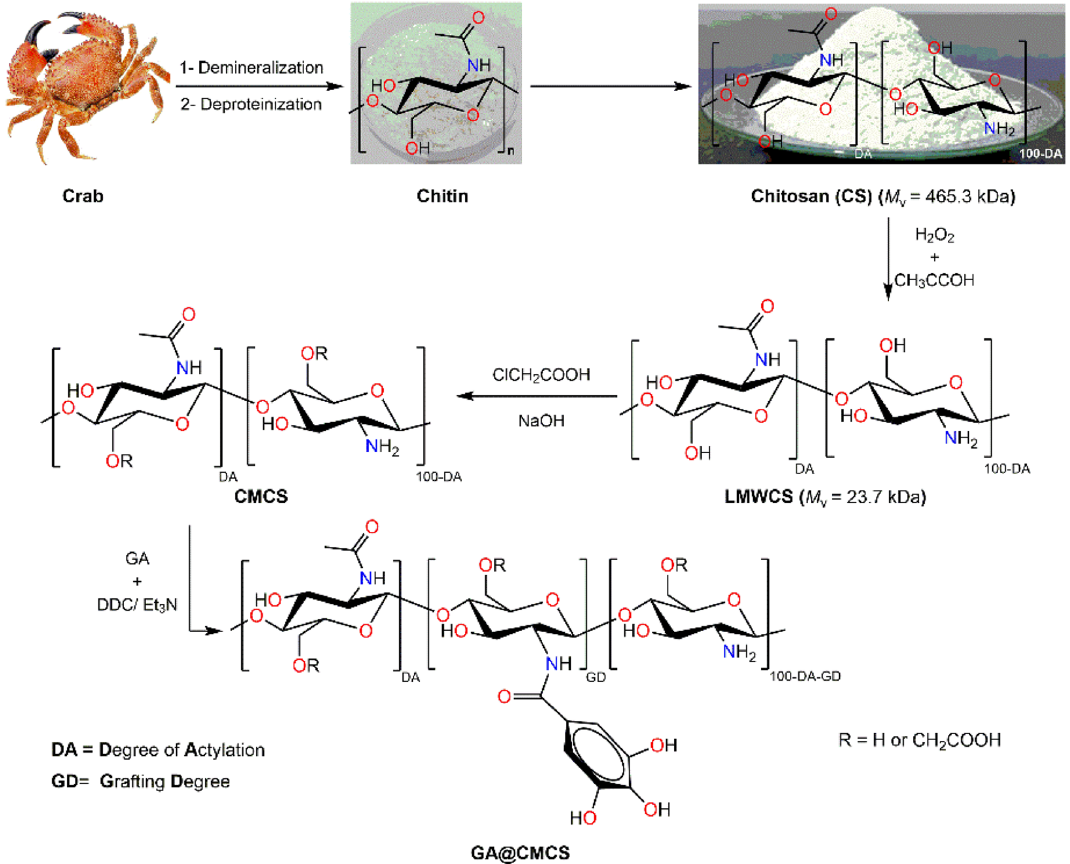
Figure 1. Schematic diagram for the extraction of crab chitosan, its partial degradation, carboxymethylation, and grafting of GA for the preparation of GA@CMCS